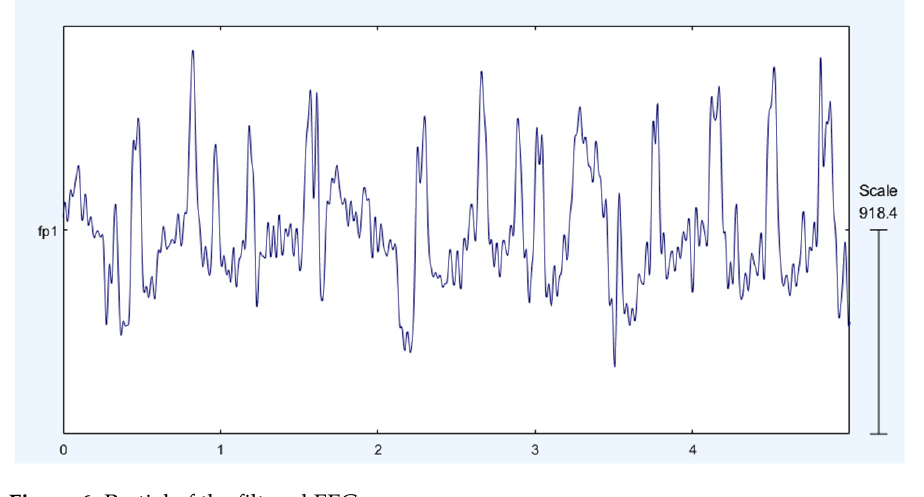
Figure 6. Partial of the filtered EEG.